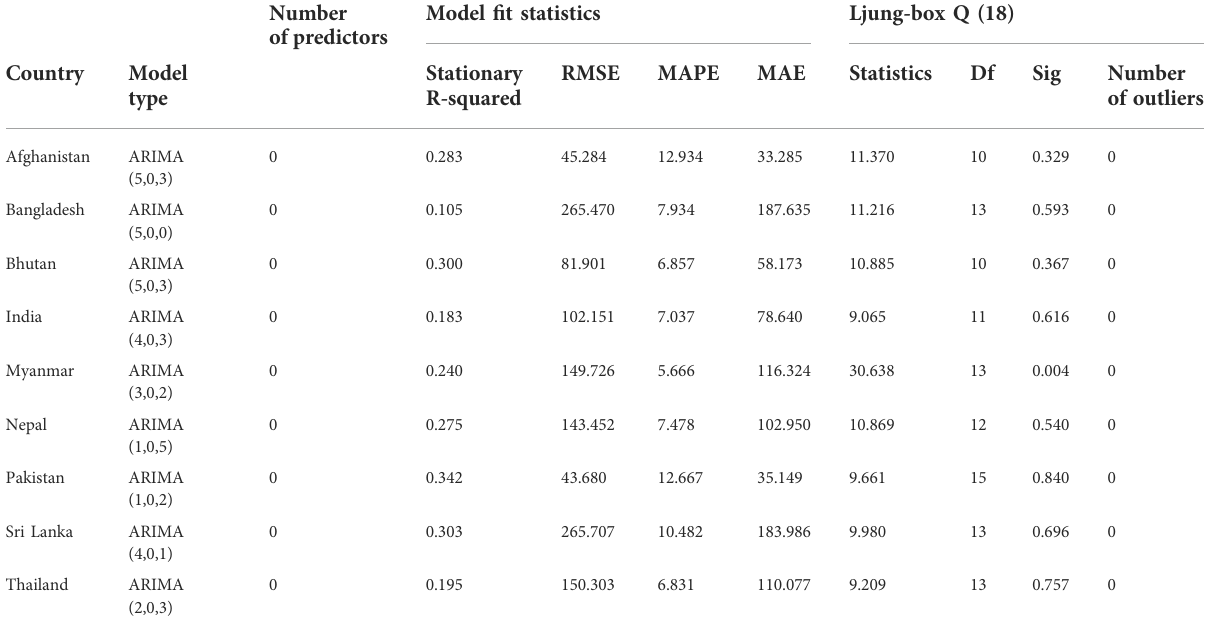
TABLE 3 Model statistics for mean annual precipitation for the countries of